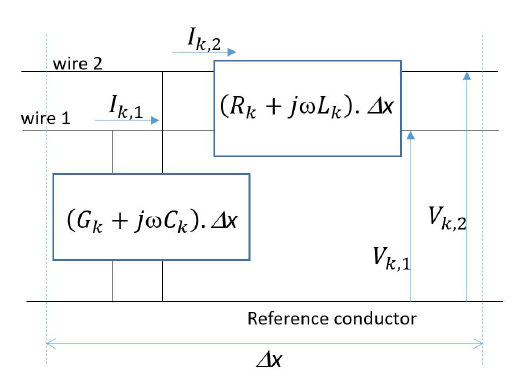
FIGURE 4: Two-wires Multiconductor Transmission Line elementary circuit cell